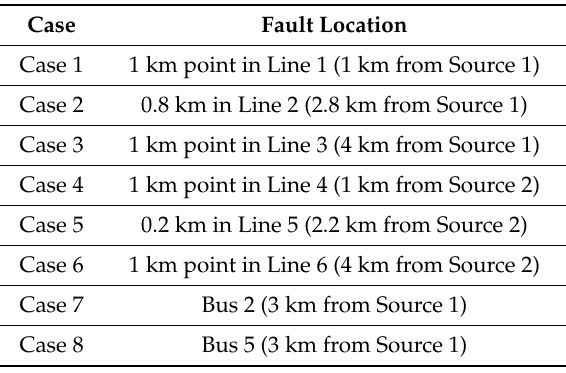
Table 1. Simulation conditions.